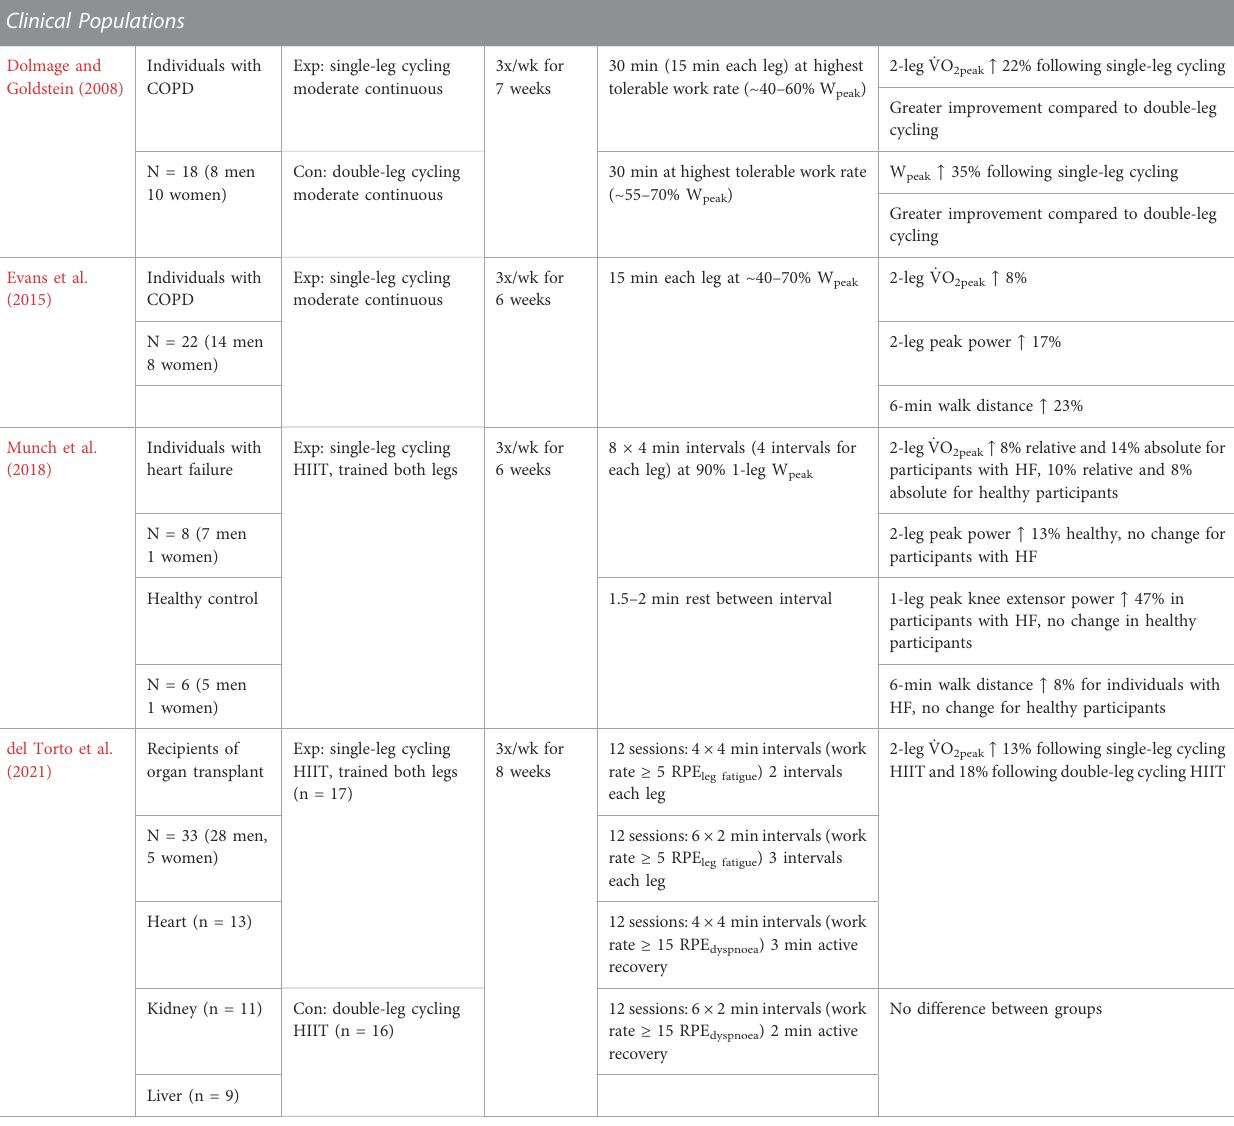
Clinical Populations